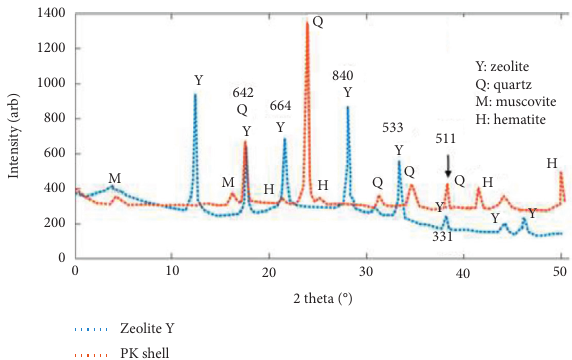
Figure 5: XRD for calcined palm kernel shell and zeolite.